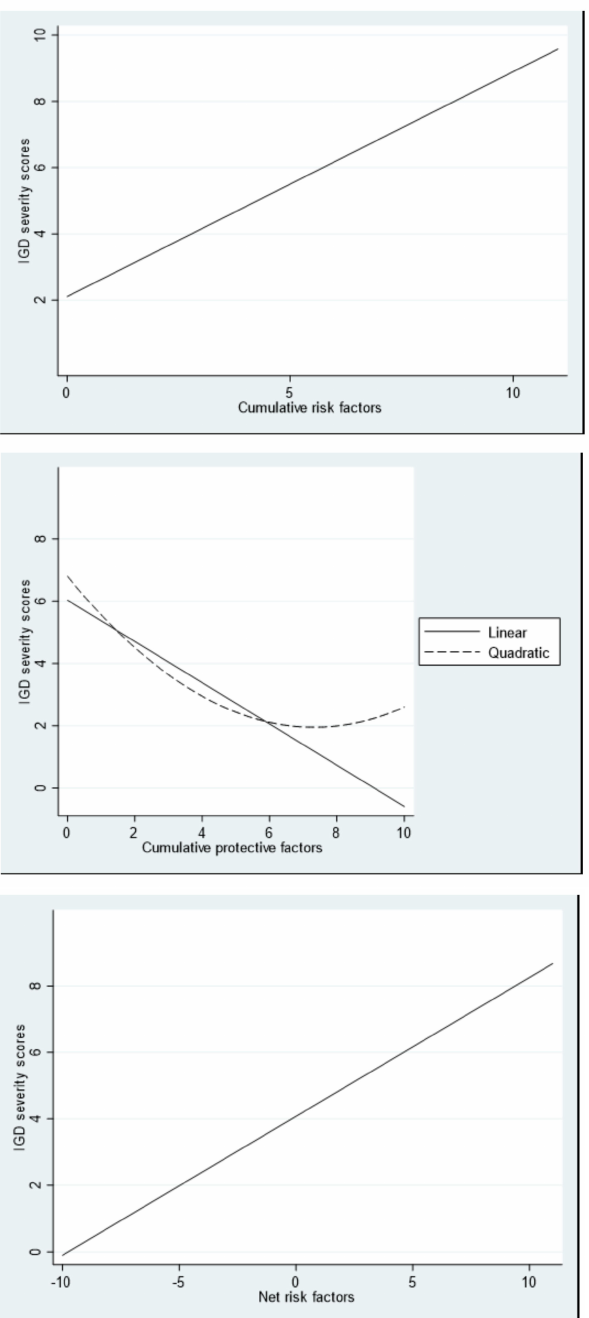
Figure 1. Significant linear/curvilinear relationships between IGD symptom severity scores and risk factors ( top ), protective factors ( middle ), and net-risk factors ( bottom